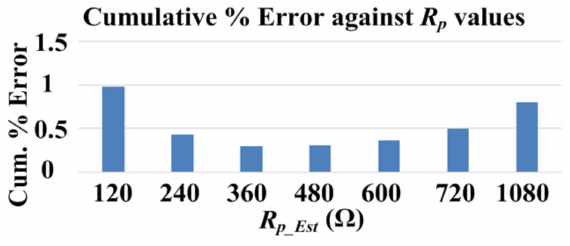
Figure 6. Cumulative % error in R p_Est